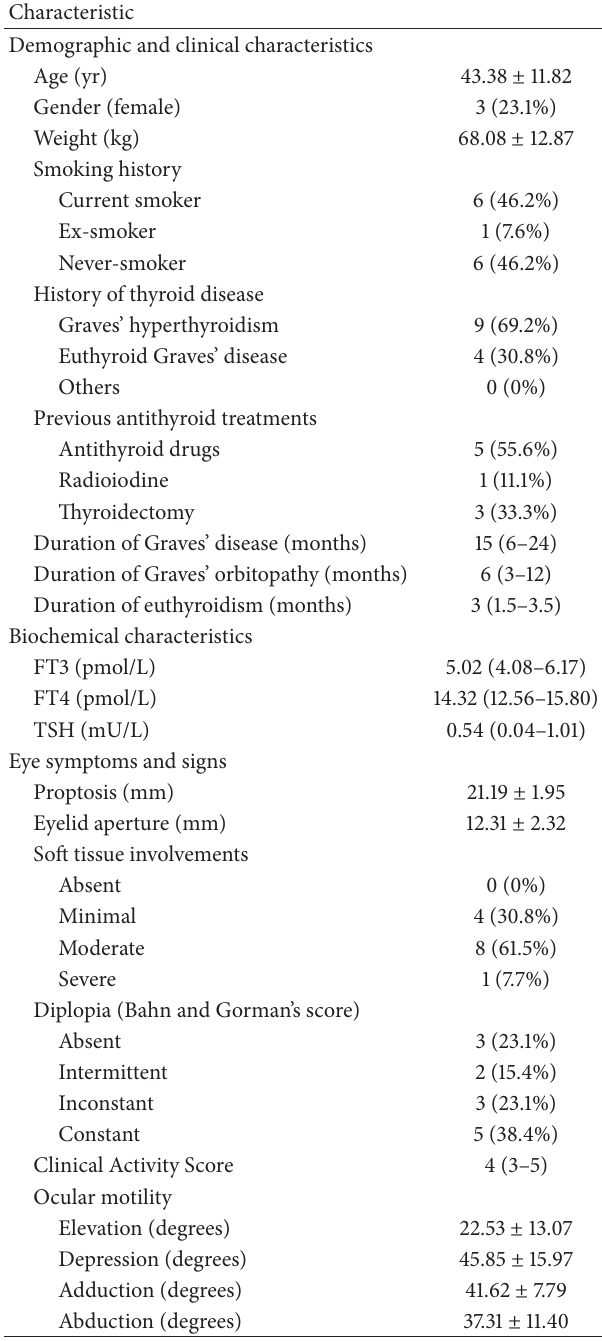
Table 1: Baseline characteristics of